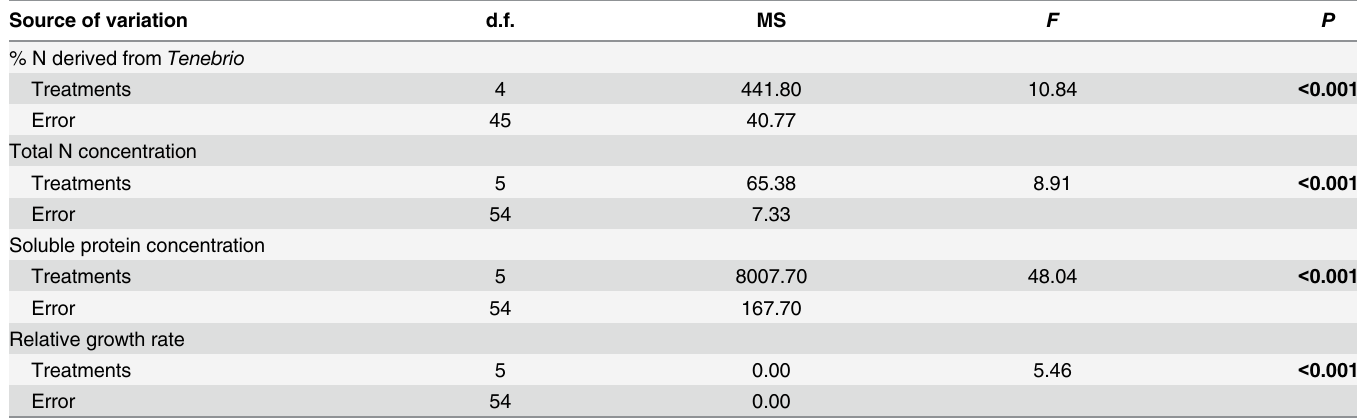
Table 2. % of N, total N and soluble protein concentrations, and relative growth rate of bromeliads. Analyses of variance (ANOVA) summarizing the effects of different treatments (control; Tenebrio larvae among roots; Tenebrio on leaves; Camponotus crassus ants and Tenebrio ; Gnamptogenys moelleri and Tenebrio ; and Odontomachus hastatus and Tenebrio ) on the % of N derived from Tenebrio , the total N and soluble protein concentrations, and relative growth rate of Quesnelia arvensis leaves. Significance of P < 0 . 05 is highlighted in